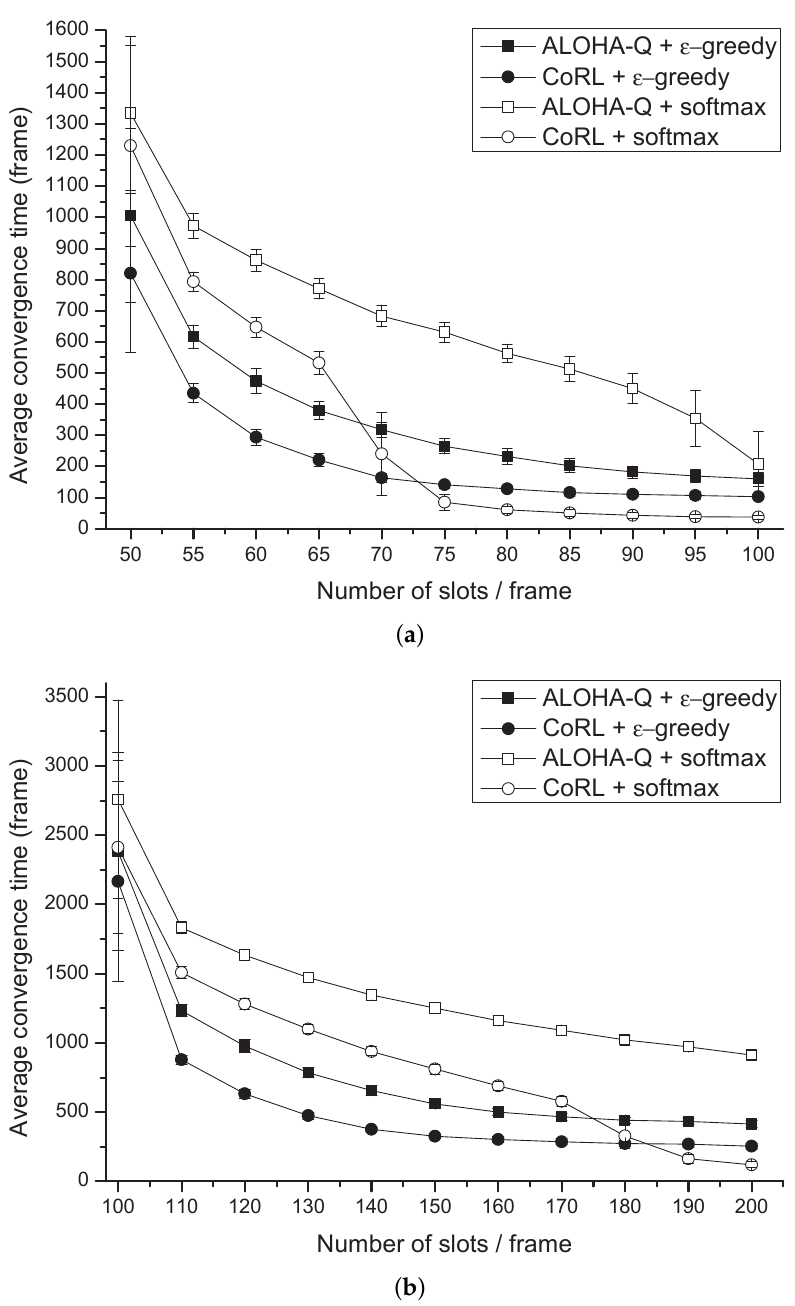
Figure 3. ( a , b ) Measures average convergence time for deprioritized services by the networks. A network of ( a ) consists the 50 nodes, and the frame contains 50 slots up to 100 slots. A network of ( b ) consists of 100 nodes, and the frame is divided from 100 slots up to 200 slots. ( a ) 50 nodes with deprioritized services. ( b ) 100 nodes with deprioritized